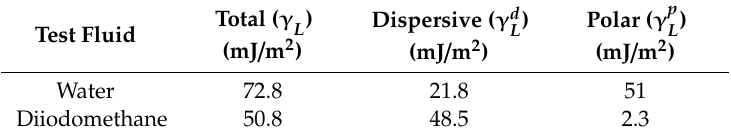
Table 1. Surface free energy values for liquids used for contact-angle measurements.